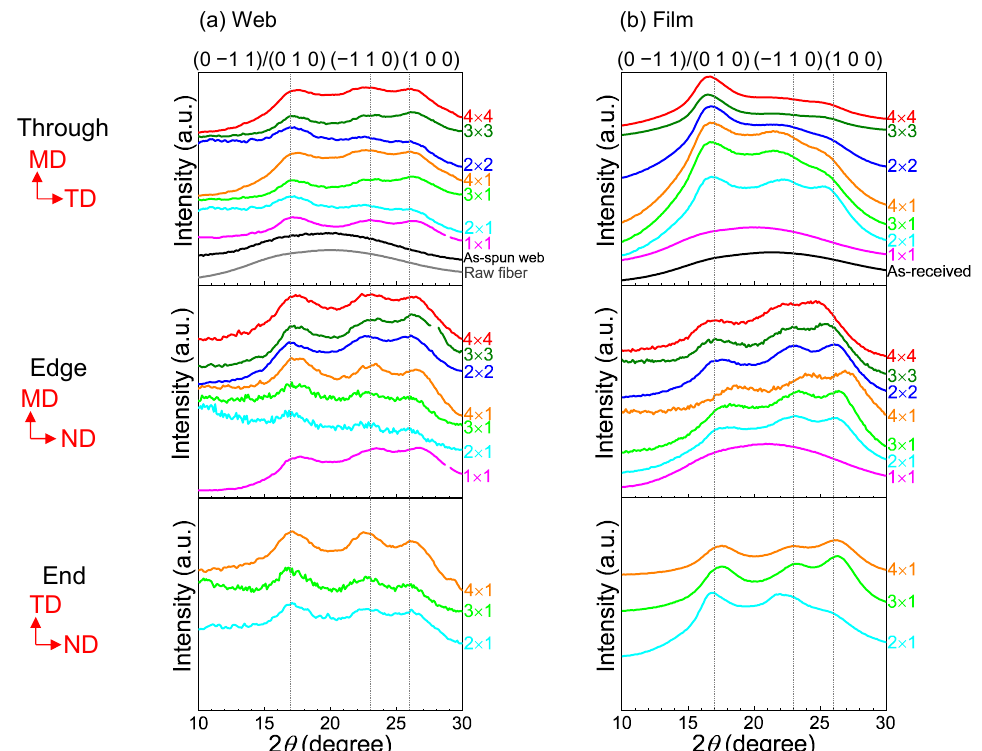
Figure 9. WAXD intensity profiles against diffraction angle for the ( a ) web and ( b ) film samples annealed after stretching to various stretch ratios. The intensity profiles were obtained by averaging the intensity along the azimuthal angle of 0 to 180°. Data for the as-received film, raw fiber for LES, and as-spun web are also included.